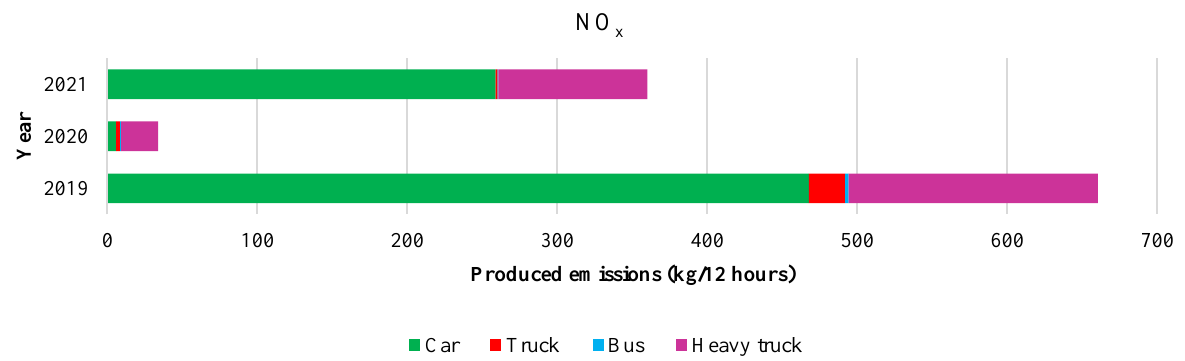
Figure 9. Estimation of CO 2 production during the simulation.